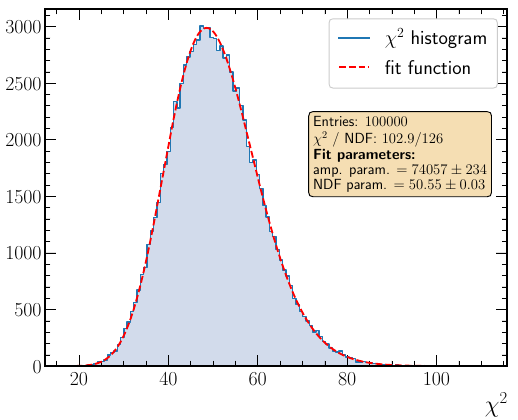
Figure 13. An example of the chi-square dis- tribution for the numerical solution of eq. (1.5) with respect to the model Born cross section. distance between the c.m. energy points and is equal to 2 MeV. The numerical solution is ob- tained using the naive method.